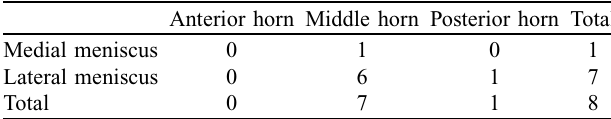
(b) after partial meniscectomy. The needle, which passes through the horizontal tear left after partial meniscectomy, indicates the place where the extraarticular procedure will be added in the next section. Table 1. Localization of the perimeniscal cysts.